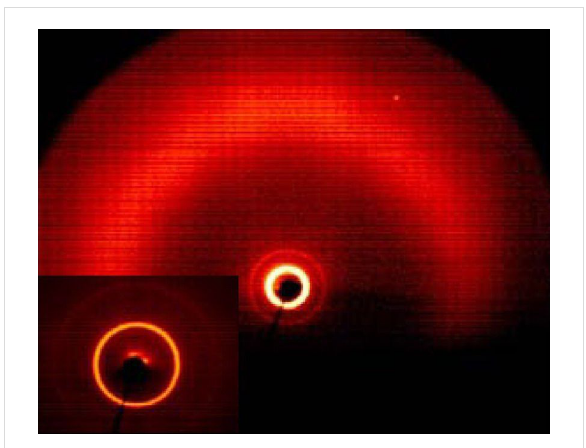
Figure 1: Polarising optical microscopy images. a) Compound OH 1a : Grainy texture with smectic Schlieren areas at 130 °C; b), c) compound OH 1c : Chiral domains of opposite handedness at 125 °C; polarisers decrossed from 90° by about +/-5°.